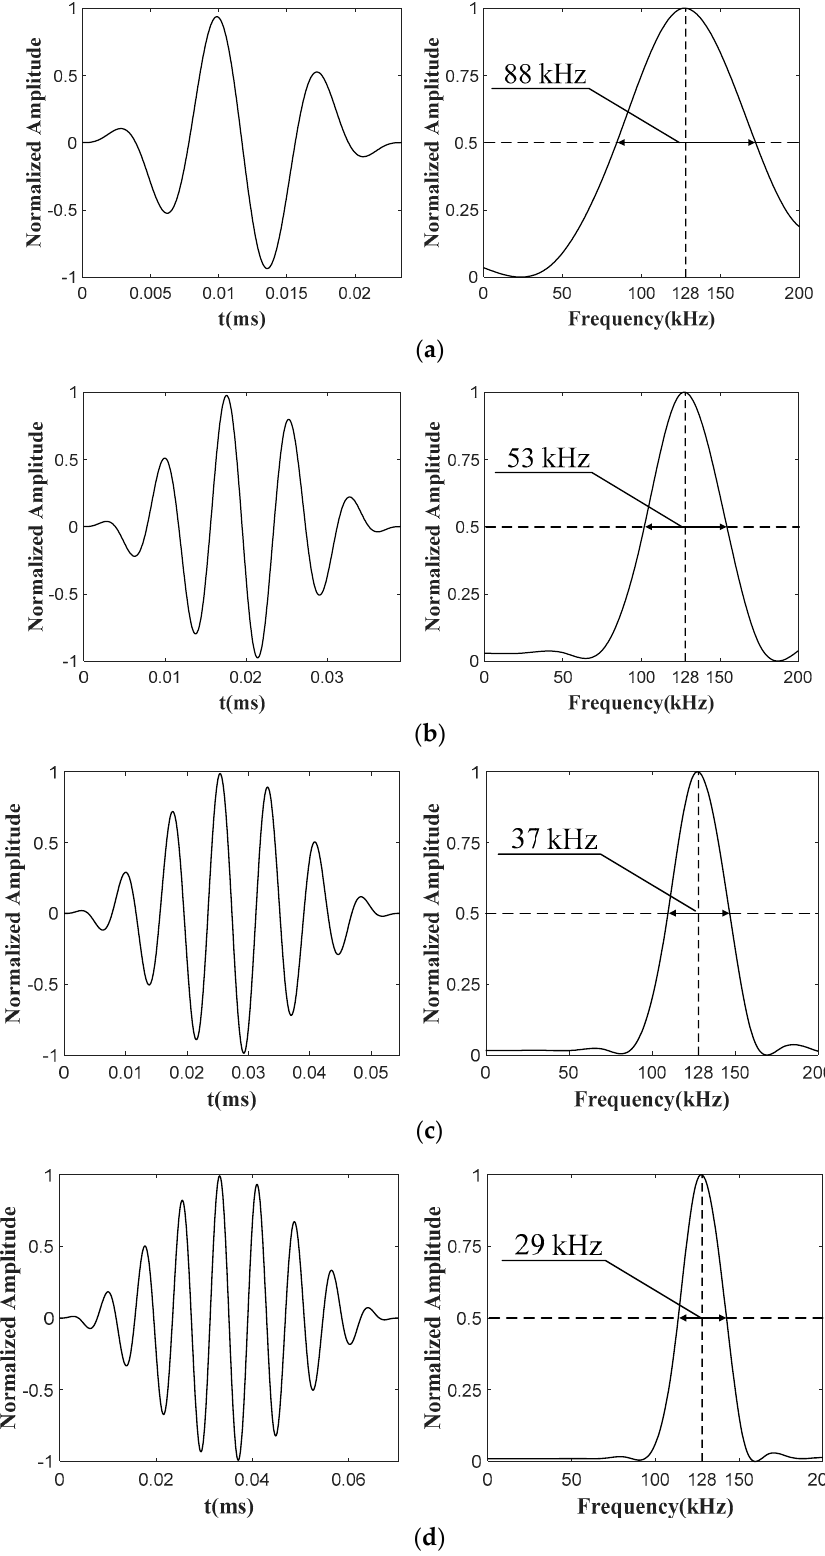
Figure 8. The excitation signals with different cycles and their amplitude spectrums: ( a ) three cycles; ( b ) five cycles; ( c ) seven cycles; ( d ) nine cycles. The half-decline frequency bandwidth of the signals is marked.